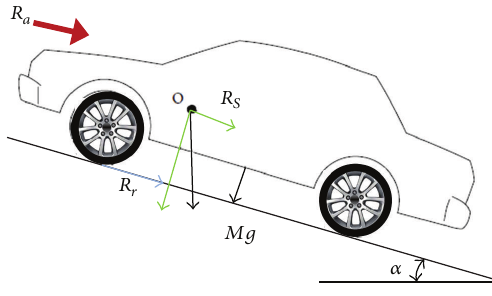
Figure 1: Forces acting on the vehicle.